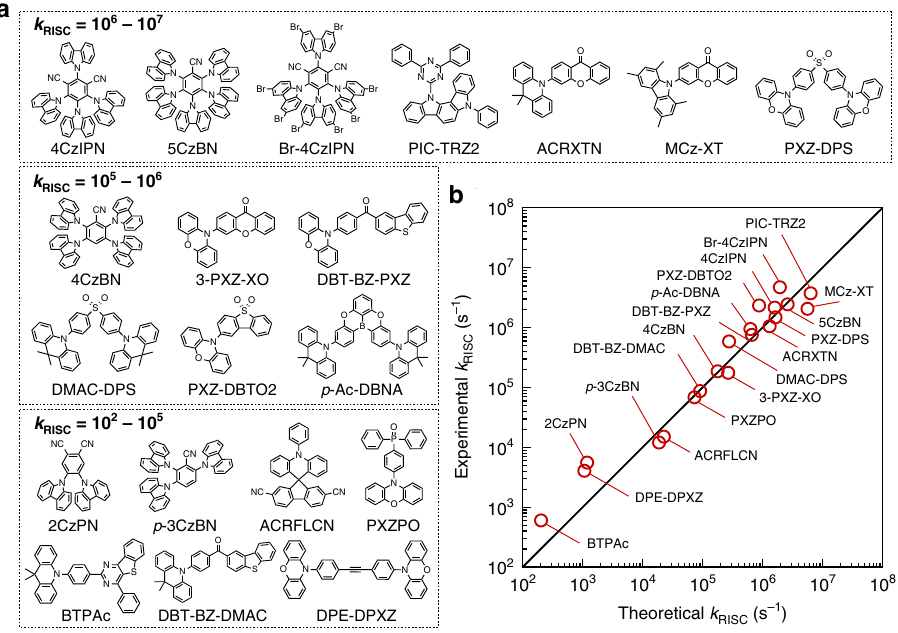
Fig. 2 Twenty molecules examined in this study and their k RISC values. a Molecular structures of the examined TADF materials categorized by their k RISC values. b Comparison of the experimental and theoretical k RISC